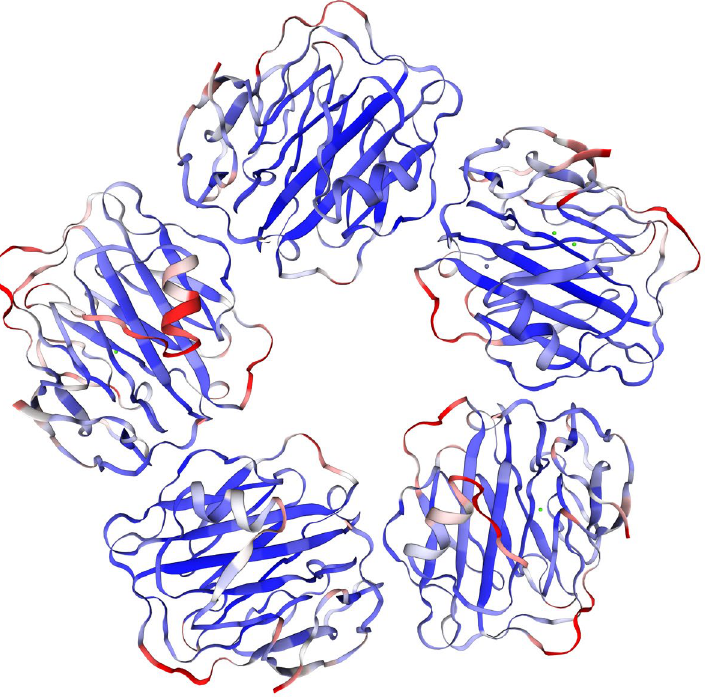
Figure 1. X-ray crystallography structure of a pentameric CRP made by Guillon and coworkers [23] and visualized using SWISS-MODEL online application [24–26].